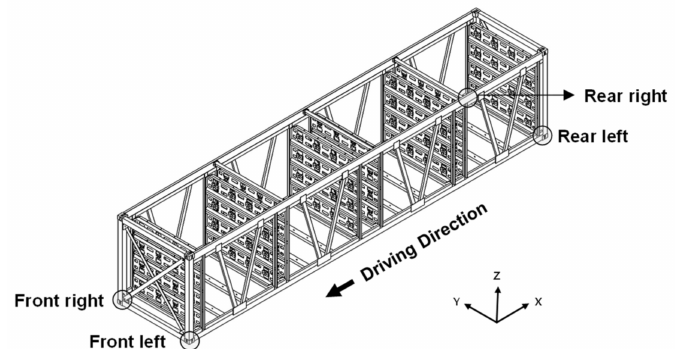
Figure 7. Acceleration calculation points and driving direction.